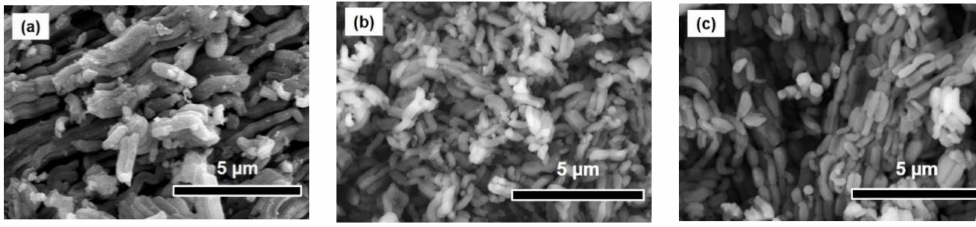
Figure 3. The SEM micrographs of SBA-15 catalysts: ( a ) mesoporous fly ash-derived SBA-15 (SBA-15-FA); ( b ) SBA-15-chemical; and ( c ) SBA-15-commercial.